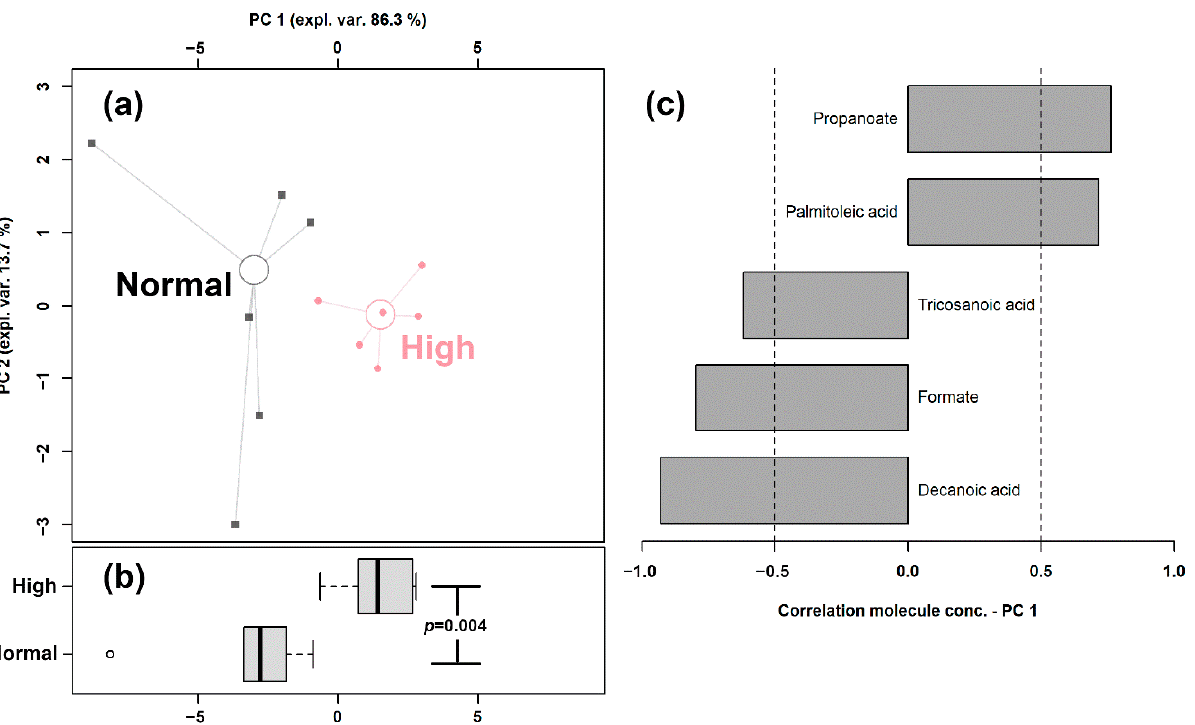
Figure 2. rPCA model built on the concentration of the fatty acids quantified in giant panda feces that showed a statistically significant difference between Normal and High shoots intake groups. In the scoreplot ( a ), samples from the two groups are represented with circles and squares, respectively. The wide, empty circles represent the median of the samples of various subjects. The position of the subjects along PC1 is summarized in boxplot ( b ). The loading plot ( c ) reports the correlation between the concentration of each substance and its importance over PC 1.